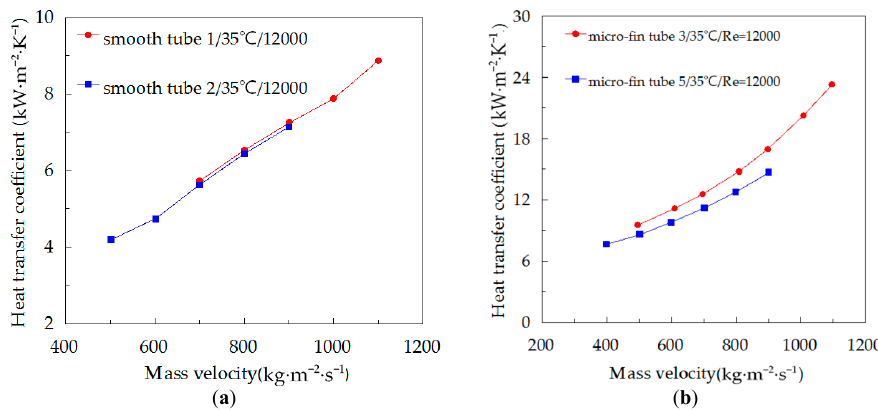
Figure 9. Influence of tube diameter on the heat transfer coefficient inside ( a ) tubes 1, 2 and ( b ) 3, 5, for R134a.